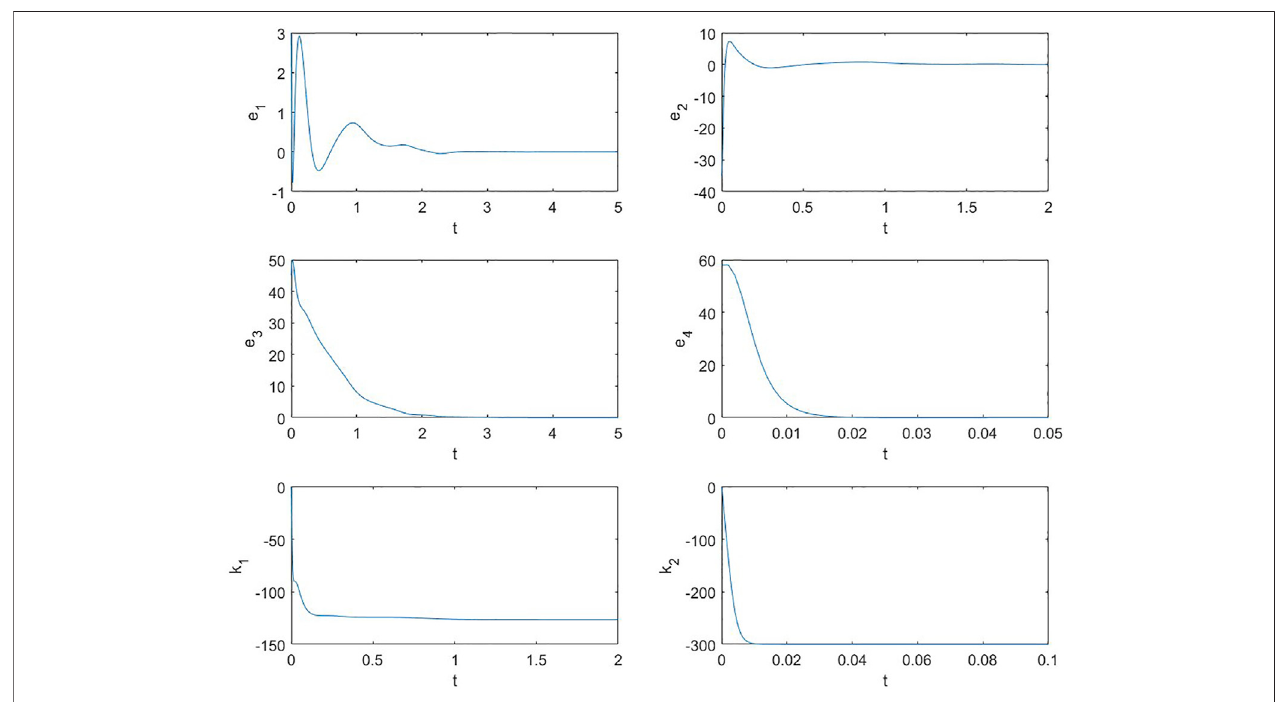
FIGURE 2 | Error synchronization by the control law ( Eq. 4 ) associated with ( Eq. 5 ).